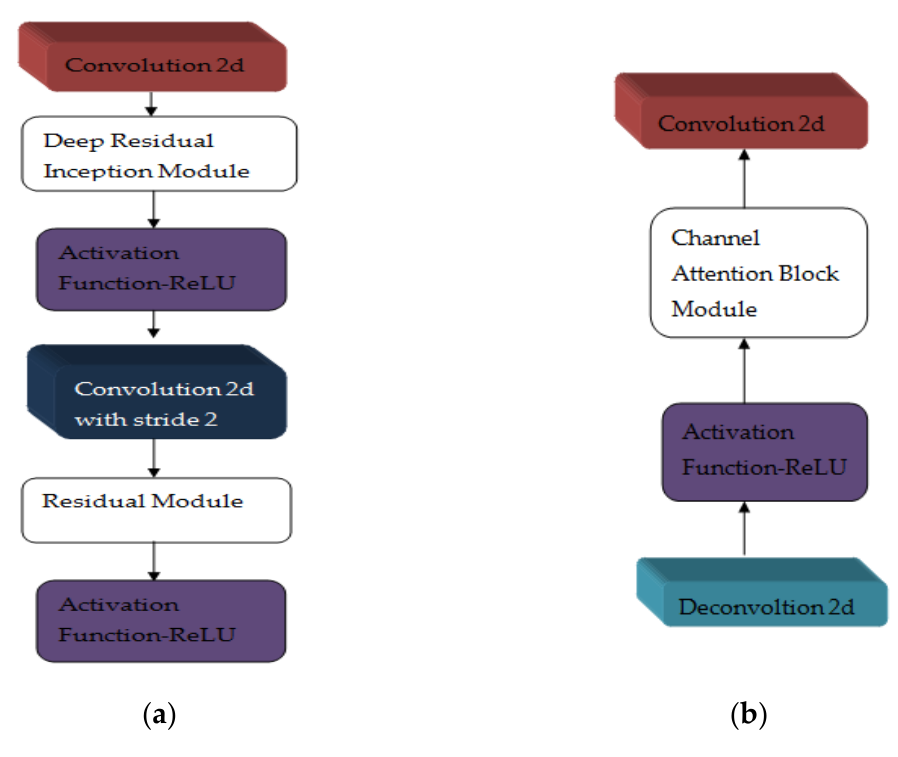
Figure 13. ( a ) RI Block ( b ) DC Block.